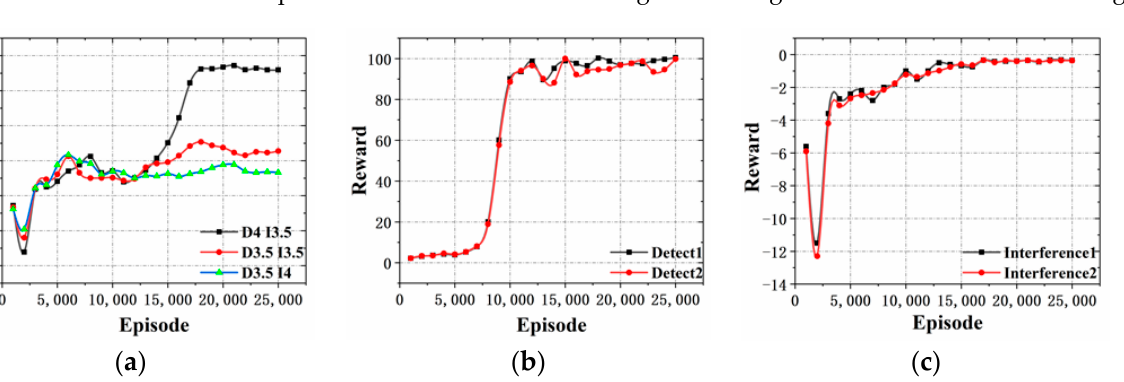
Figure 9. Reward function curves for multi-agent confrontation environment experiments: ( a ) reward function curves for the blue detection multi-agent and the red interference multi-agent for different acceleration parameters(“D4,I3.5” indicates V L = 4, V R = 3.5; “D3.5,I3.5” indicates V L = 3.5 and V R = 3.5; “D3.5,I4” indicates V L = 3.5 and V R = 4); ( b ) plot of the reward function for the blue detection agents, and ( c ) shows the plot of the reward function for the red interference agents.